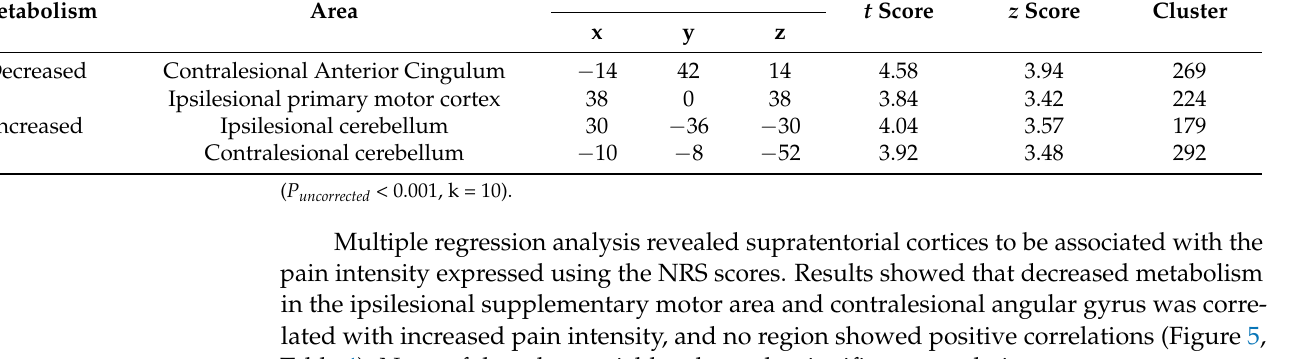
Figure 5. Statistical parametric maps demonstrating the regions with decreased pain intensity correlated with increased pain intensity. ( P uncorrected < 0.001, k = 10).